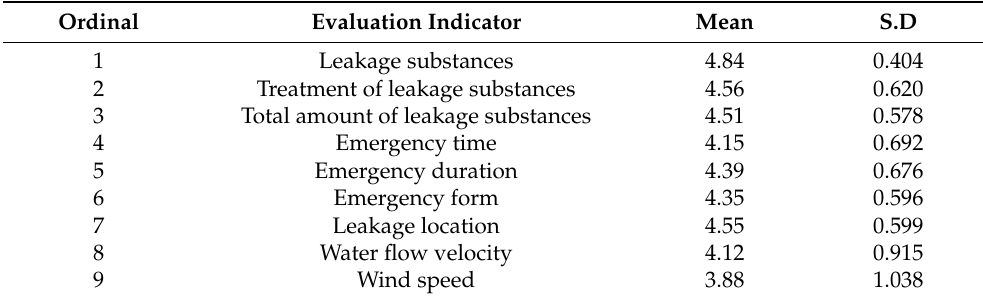
Table 3. Affecting factors and grading indicators study result.